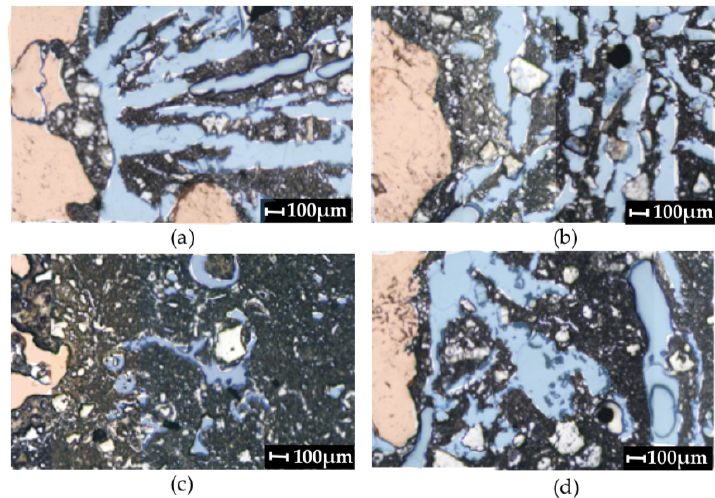
Figure 10. Optical microscope observations of: ( a ) mixture 1A before curing, ( b ) mixture 1D before curing, ( c ) mixture 1A after 3 days of curing, and ( d ) mixture 1D after 3 days of curing. Areas that are shaded in orange correspond to slag particles, and the blue shaded areas corresponds to voids that were filled by epoxy